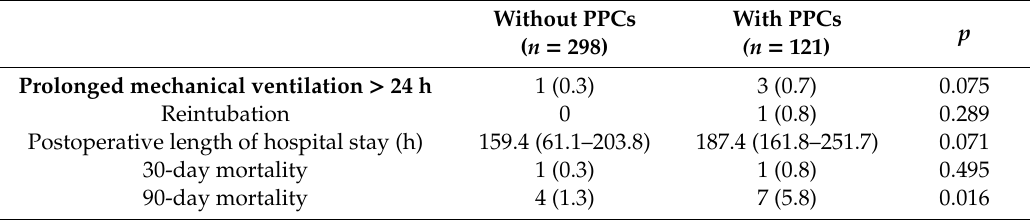
Without PPCs With PPCs p (n = 121) ( n = 298)